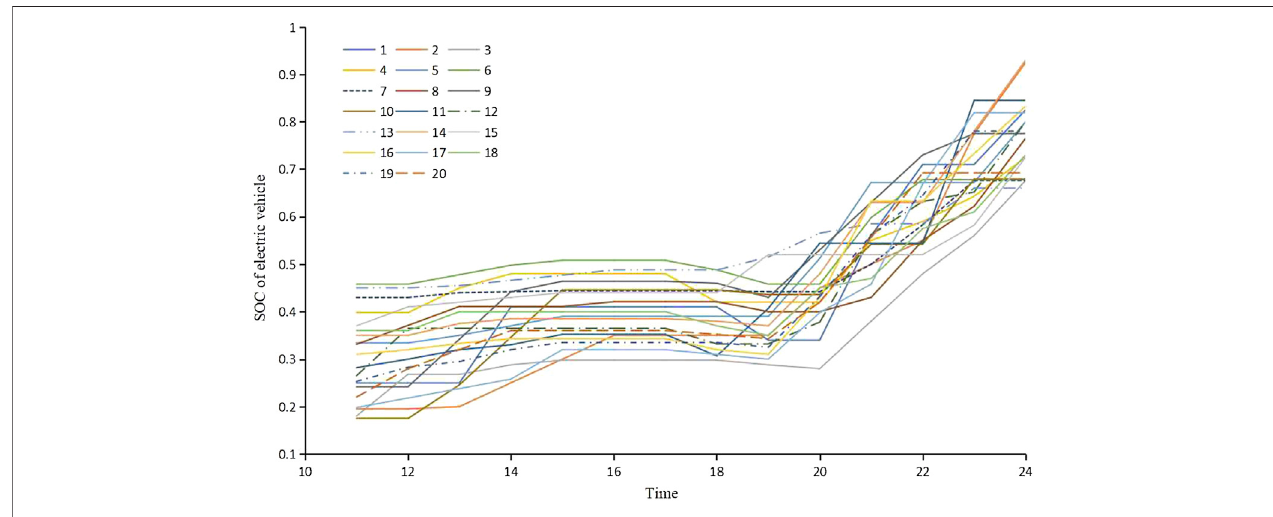
FIGURE 4 | SOC of electric vehicles before collaborative management and control.